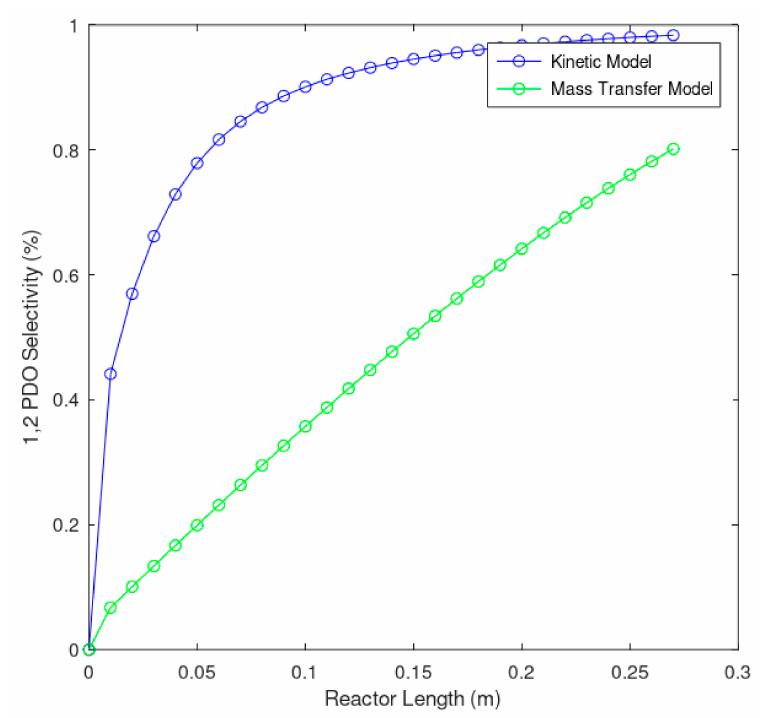
Figure 5. Selectivity of 1,2 propanediol through the